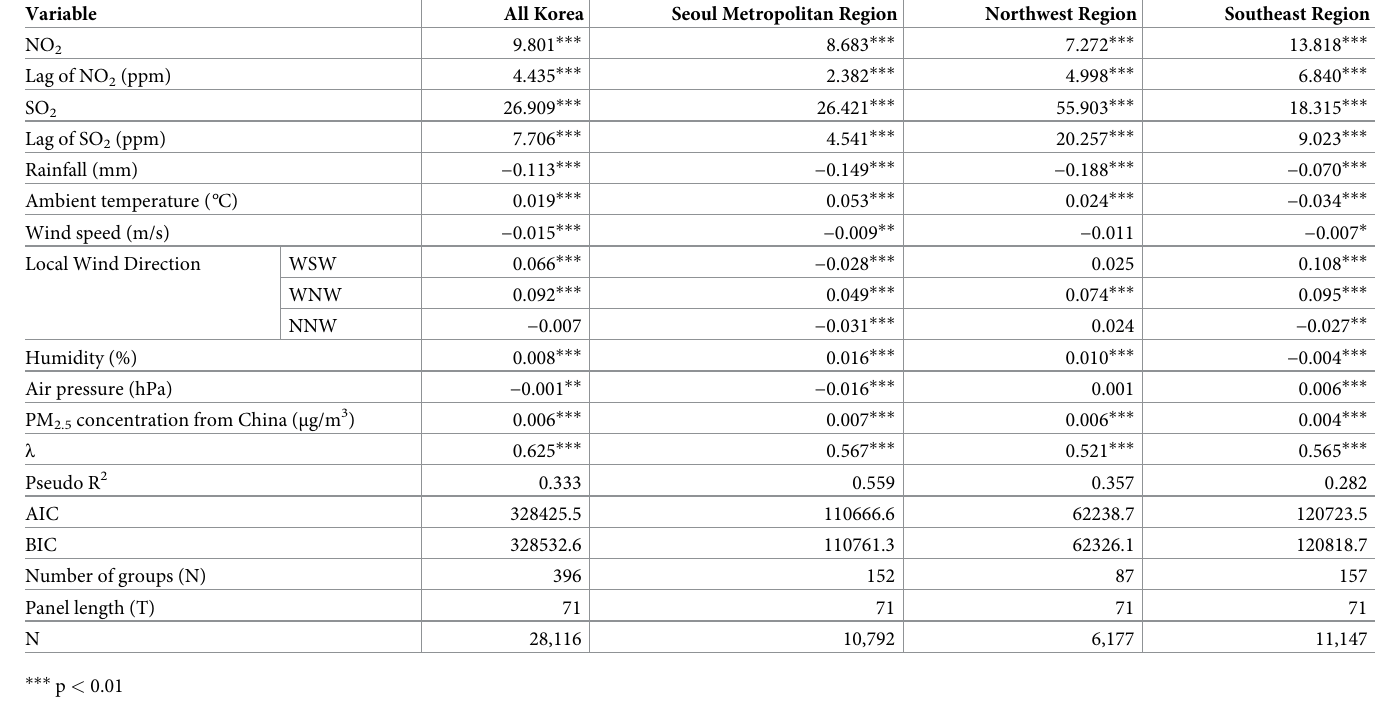
Table 3. Spatial panel-data FE model results.